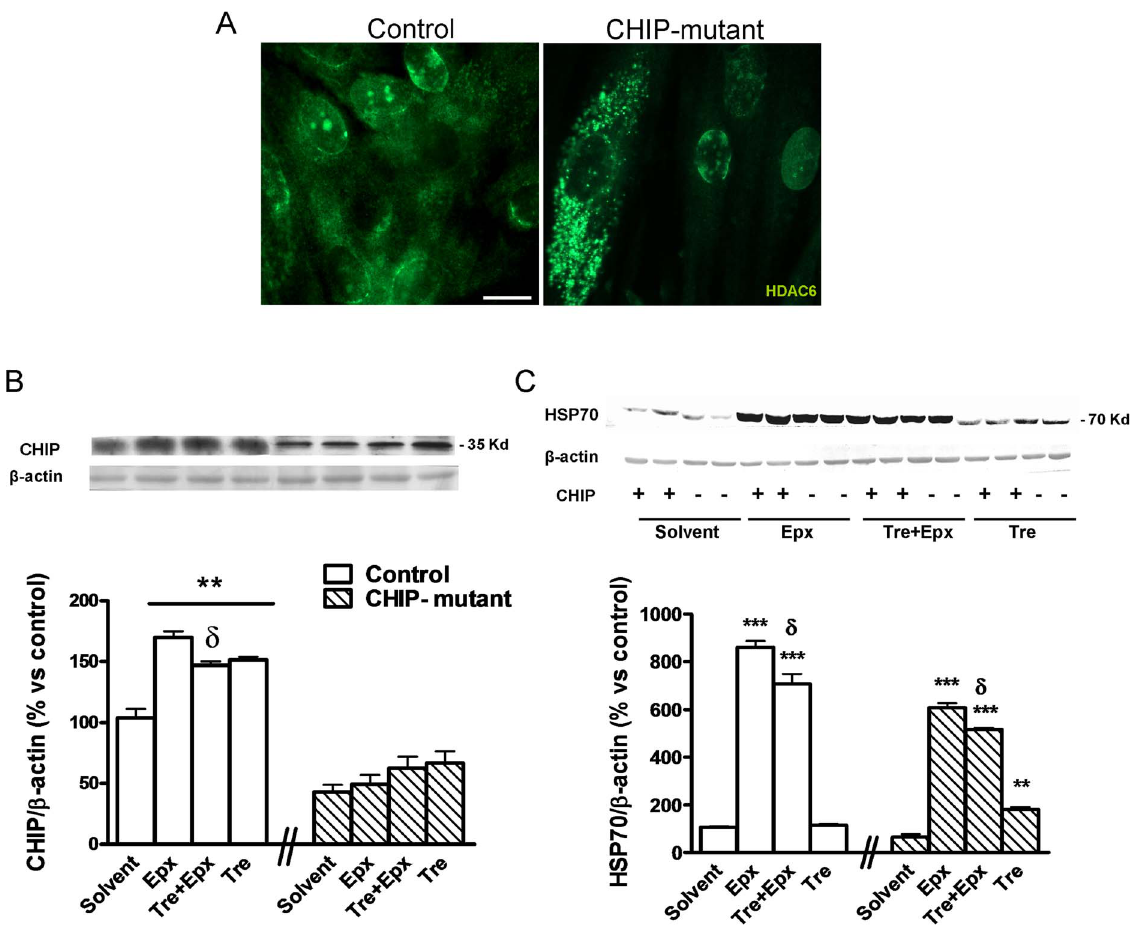
Figure 1. CHIP, HSP70 expression and HDAC6 accumulation in control and CHIP-mutant fibroblasts. Effects of epoxomicin and trehalose on chaperone proteins. After 3 days in vitro, the cells were pre-treated with trehalose (50 mM) for 15 minutes followed by addition of epoxomicin (10 nM) or solvent for another 24 h. A ) Representative image of control and CHIP-mutant fibroblasts immunostained with antibody to HDAC6 (a substrate of CHIP). B ) Representative bands and quantification of CHIP and C ) HSP70 Western blot. b -actin was used as an equal loading of proteins. In 1A, a total of 120 cells in 5 coverslips were analyzed in both groups. Data of the control and CHIP-mutant groups were analyzed independently, no inter-group statistical analysis was performed. Data are expressed as the mean 6 SEM values. Values of 1B and 1C correspond to the mean of two experiments with 4 independent cell dishes of 3 different controls (n=3). In the CHIP-mutant case six independent dishes of one patient (pseudo-replicates, n=6). Statistical analysis was performed by Student’s t-test. *p , 0.05, **p , 0.01, ***p , 0.001 vs solvents; d p , 0.05 trehalose + epoxomicin vs epoxomicin-treated cultures.